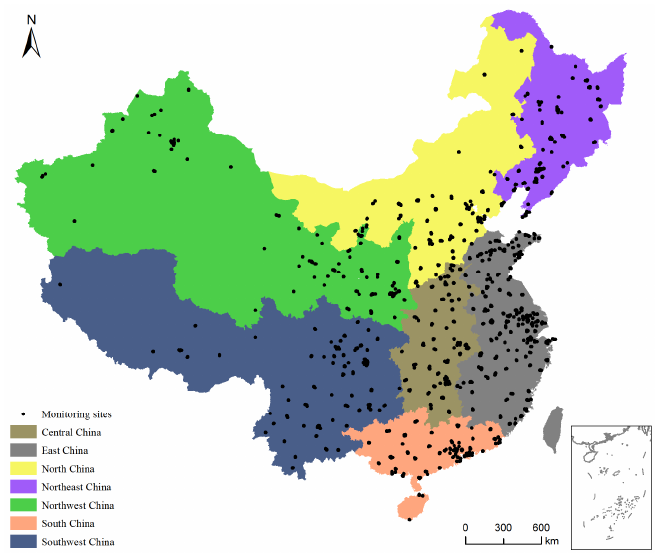
Figure 1. Geographic locations of the monitoring sites in China.